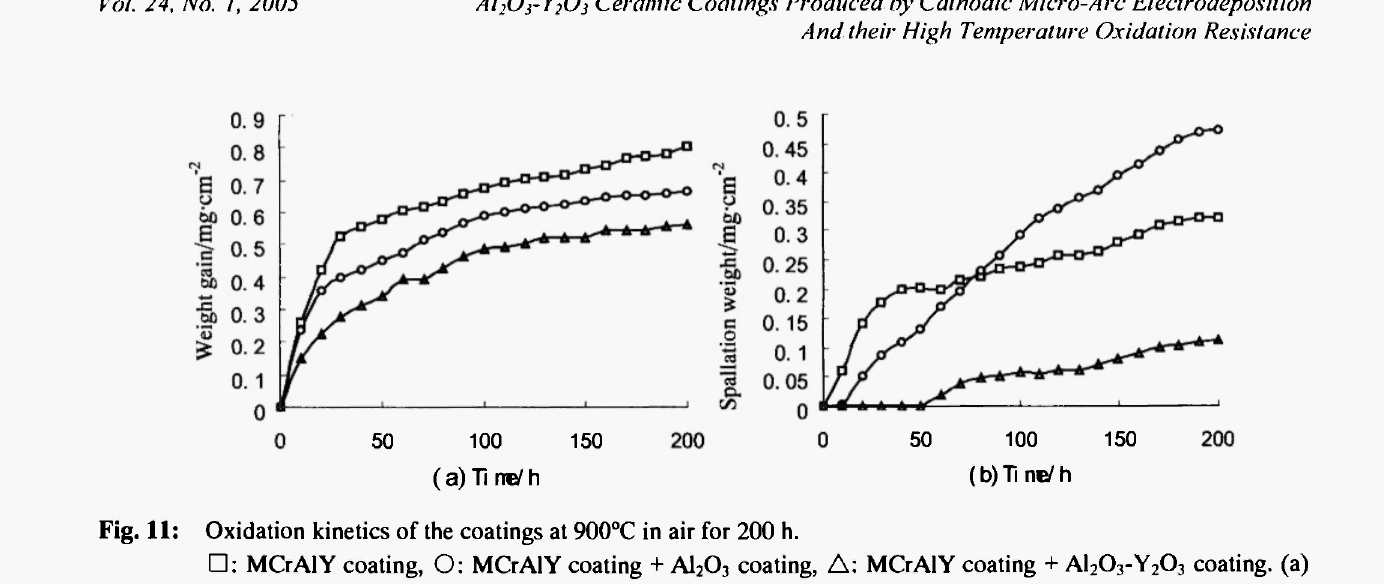
Fig. lis Oxidation kinetics of the coatings at 900°C in air for 200 h. • : MCrAlY coating, O: MCrAlY coating + A1 2 0 3 coating, Δ: MCrAlY coating + Al 2 0 3 -Y 2 03 coating, (a) Mass gain vs. time and (b) oxide spallation vs.